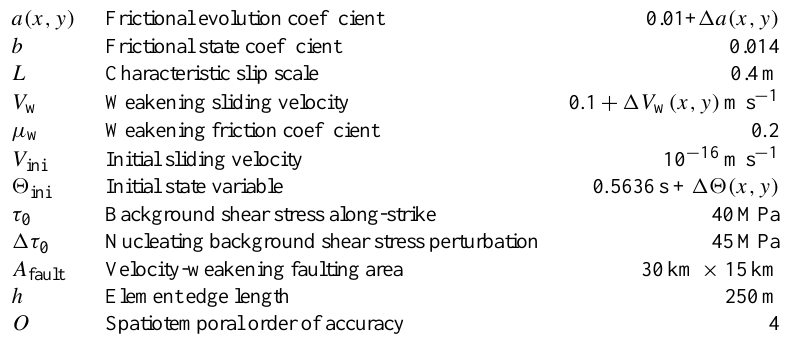
Fig. 16. Fast velocity-weakening benchmark TPV103 results. Comparison of ADER-DG (black) with the high-order dynamic rupture software packages MDSBI, SPECFEM3D and a SBIE implementation. Along-strike (a) shear stress and (c) slip rate on the fault at 12km along-strike and 3km along-dip. Along-strike (b) shear stress and (d) slip rate during nucleation at the hypocenter at strike 0km, dip 7 . 5km. The ADER-DG solution is shown in black, the comparison solutions of MDSBI in green, SPECFEM3D in blue and SBIE in purple. Table 6. Simulation parameters for SCEC test case TPV103, which differ from test case